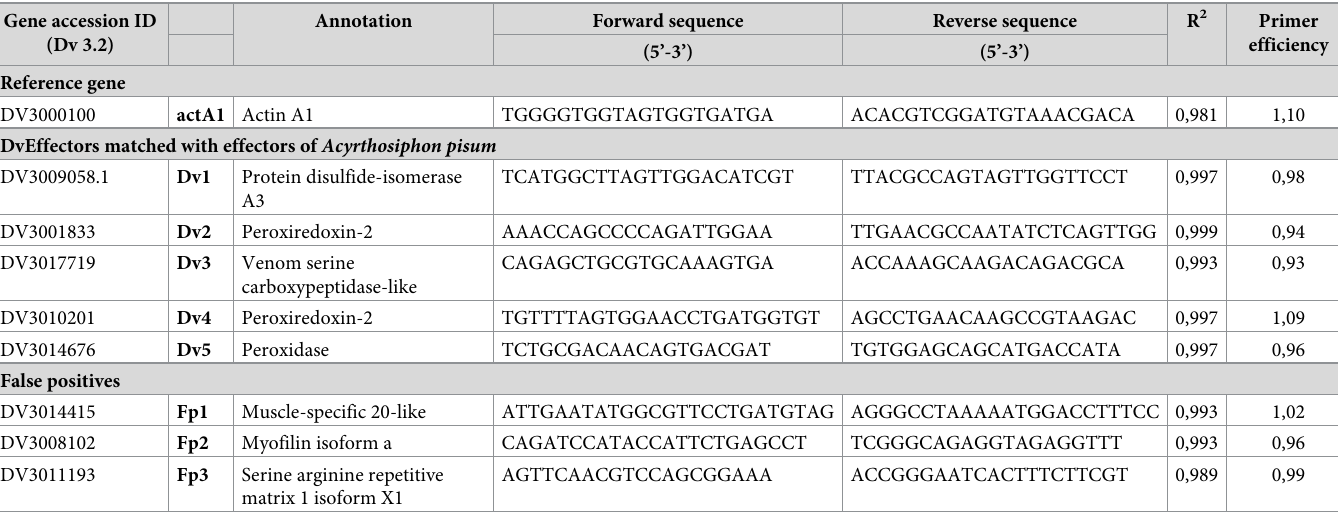
Table 1. Analysed DvEffector genes and primers used for qRT-PCR. Gene accession ID (Dv